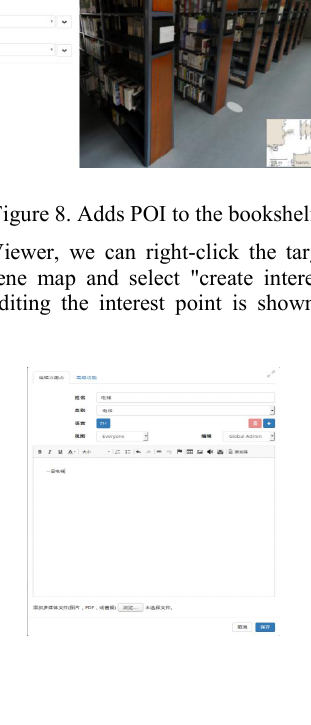
Figure 10. Created data sets and